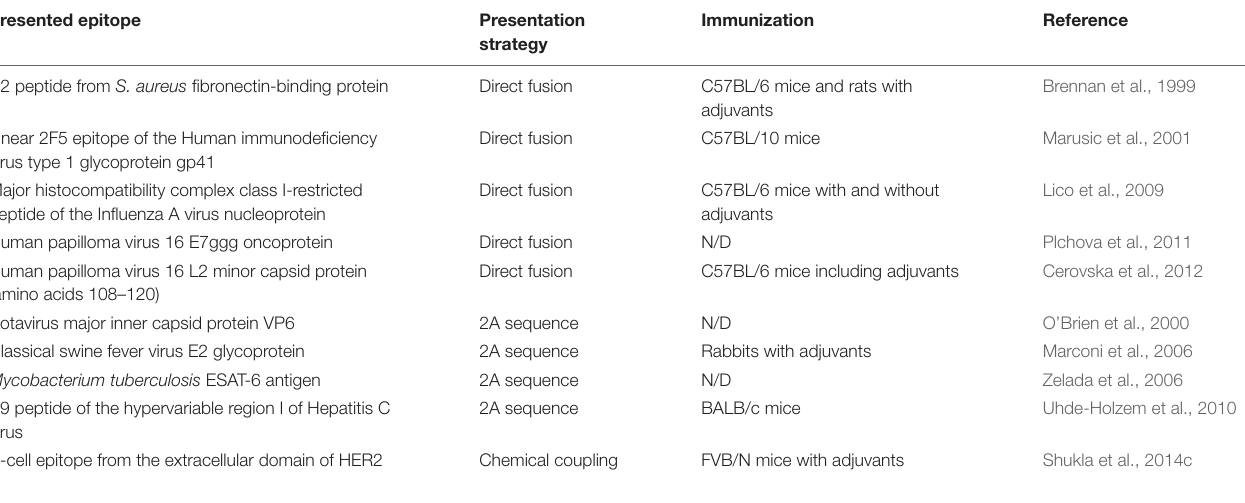
TABLE 1 | Epitopes presented on PVX-based VNPs for vaccination applications. Presented